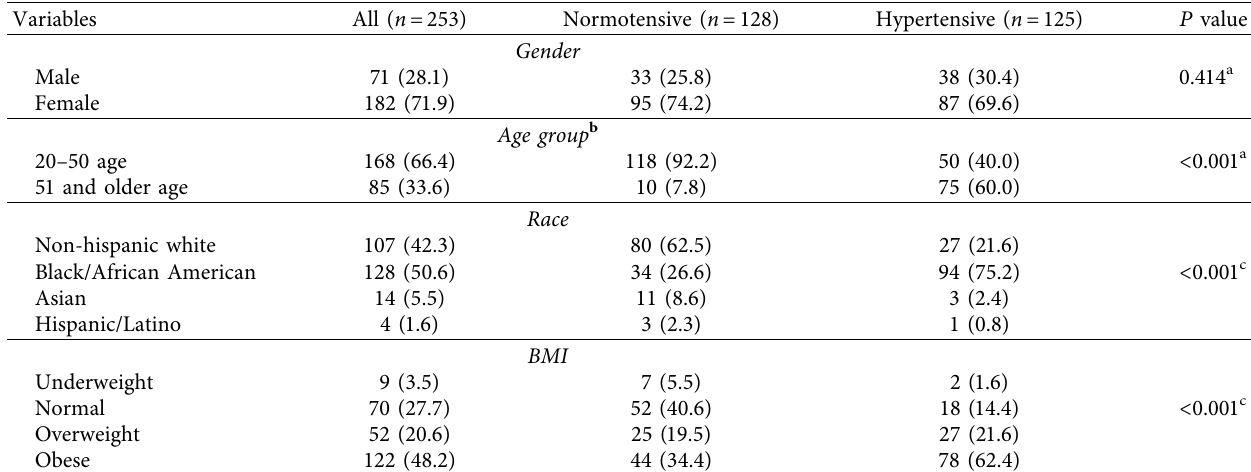
Table 3: Demographic variables of 253 adults with and without